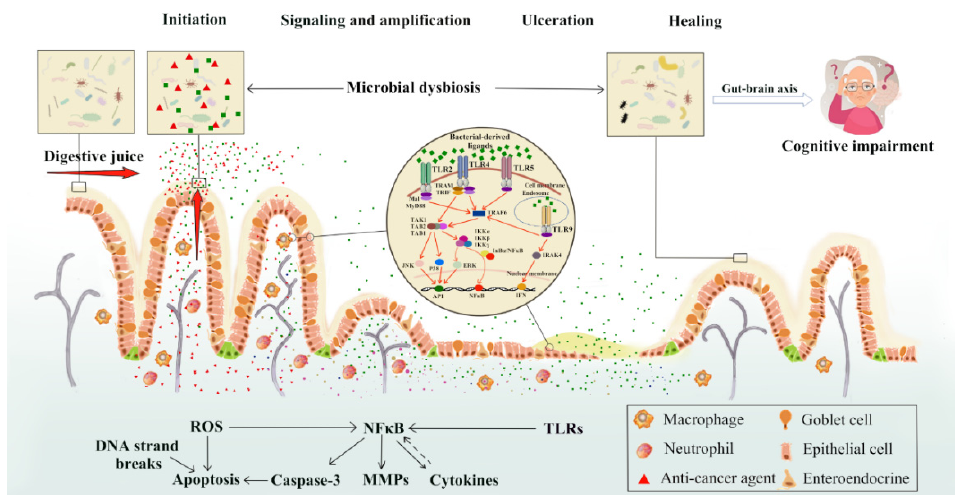
Figure 1. New perspectives on impacts of chemotherapy-induced intestinal microbial dysbiosis on pathogenesis of mucositis and the non-intestinal manifestations of mucositis. On the basis of the five-phase model for chemotherapy-induced mucositis put forward by Sonis in 2004, this review proposed the possible roles of intestinal microbial dysbiosis at various phases of mucositis pathogenesis and in the cognitive impairment of patients/survivors. Chemotherapy drugs or their metabolites may percolate into intestinal mucosa and may also be secreted along with various digestive fluids, directly destroying the bacteria in the gut lumen, altering their total numbers and compositions. Cell wall components of the killed bacteria are recognized by toll-like receptors (TLRs), such as peptidoglycan through TLR-2, lipopolysaccharide (LPS) through TLR-4, flagelin through TLR-5 and non-methylated DNA (CpG DNA) through TLR-9. All TLRs recruit adaptor proteins via the myeloid differentiation factor 88 (MyD88)-dependent pathway and/or adaptor-inducing interferon- β (TRIF)-dependent pathway to activate NF- κ B and/or ERK/JNK/p38 kinases, which further lead to increased expression of inflammatory mediators. Intestinal microbial dysbiosis may further affect the mental health of patients/survivors through the microbiota- gut-brain axis. MAL: MyD88-adaptor like protein; IRAK: interleukin-1 receptor associated kinase; TRAF6: TNF- α receptor association factor 6; TAK: thylakoid associated kinase; TAB: TAK-binding protein; NF- κ B: nuclear factor- κ B; I κ B: NF- κ B inhibitor; IKK: I κ B kinase; ERK: extracellular signal-regulated kinase; JNK: c-Jun N-terminal kinase; AP-1: activator protein 1; IFN: